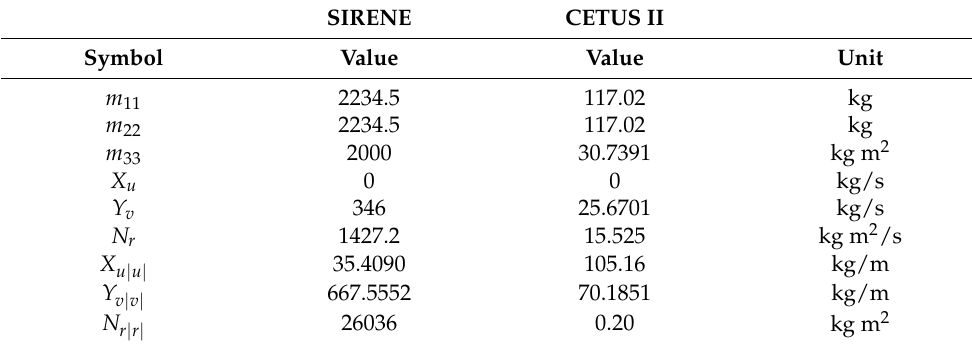
Table 1. Parameters of the SIRENE and CETUS II.